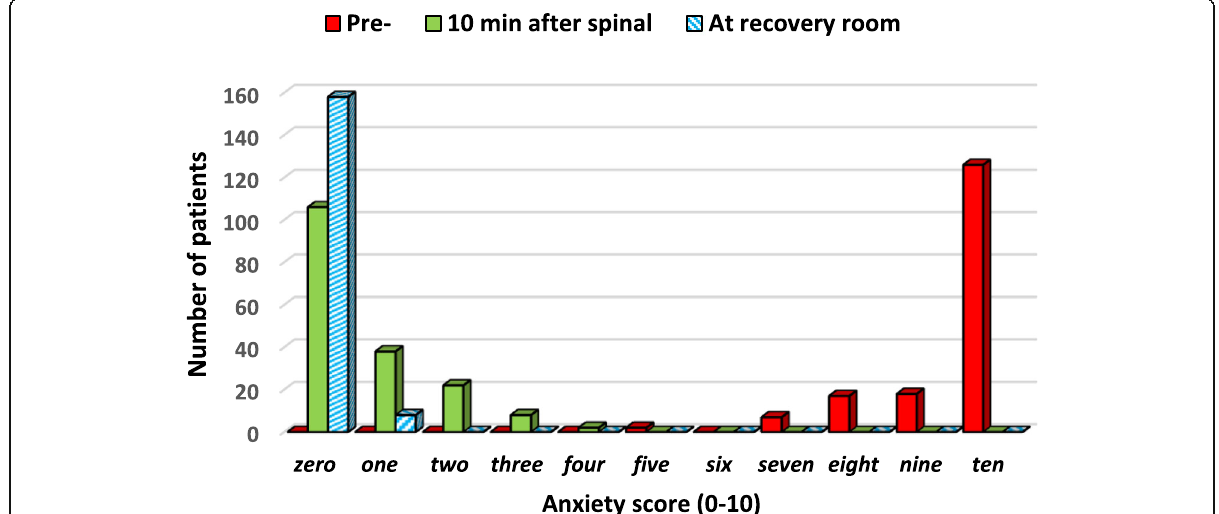
Fig. 5 The anxiety score for patients in spinal group under PPS; preoperatively, 10 min after spinal injection, and at recovery room. Data are presented in number, n = 166